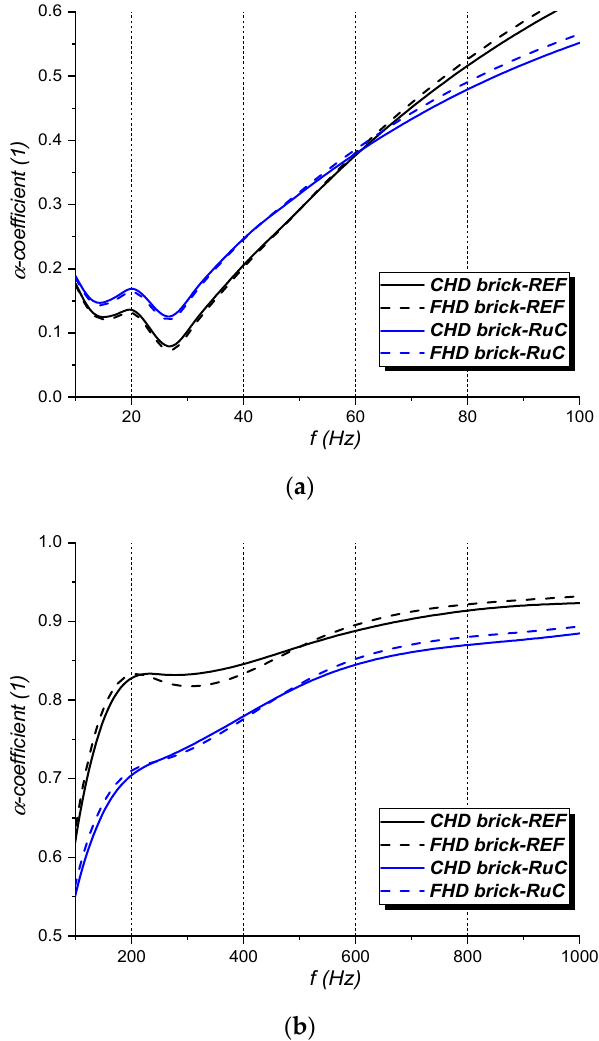
Figure 15. FEA-based acoustic results: ( a ) low-frequency α -coefficient curves and ( b ) middle-high- frequency α -coefficient curves.